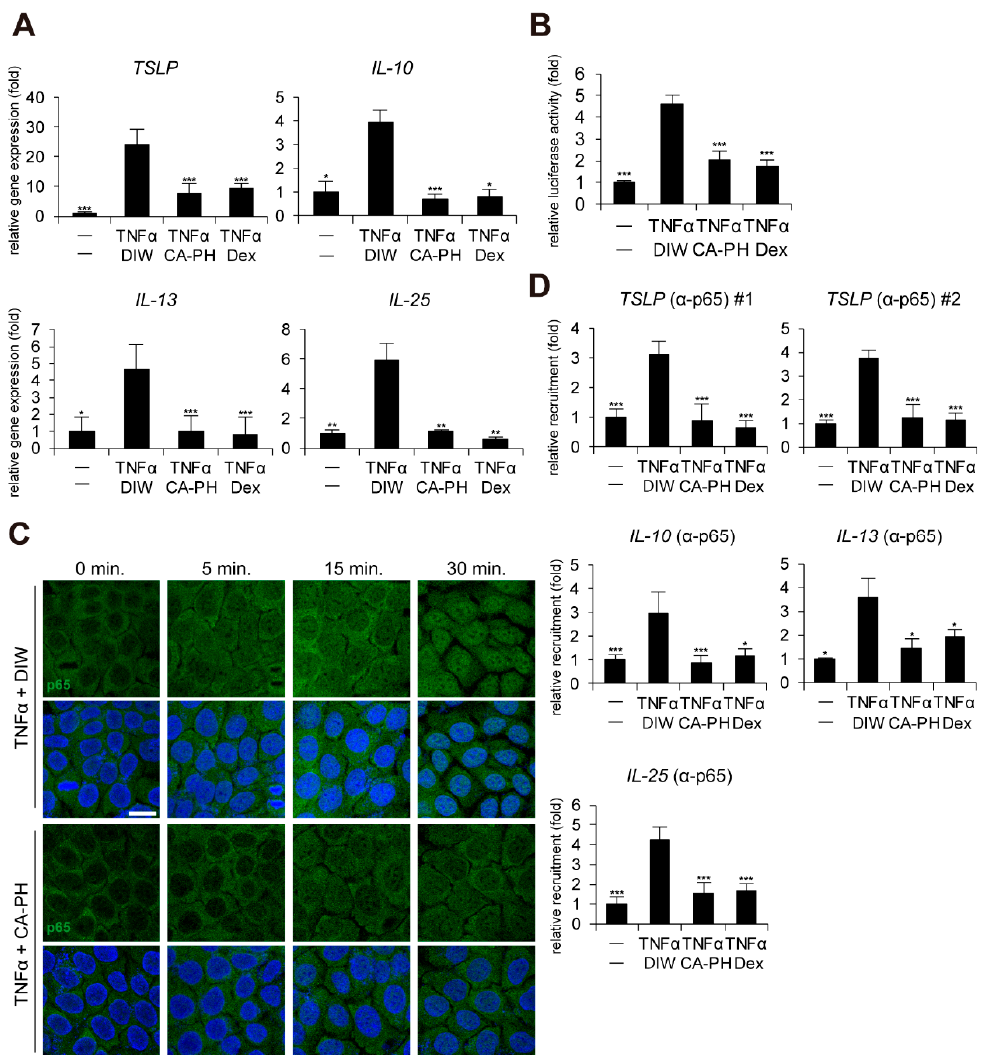
Figure 2. CA-PH inhibits NF- κ B signaling in TNF α -treated keratinocytes. ( A ) CA-PH suppresses DNFB-induced up-regulation of cytokine expression in TNF α -treated HaCaT keratinocytes. Dex was used as the positive control. DIW was used as a solvent for TNF α and CA-PH. Transcripts of TSLP, IL-10, IL-13, IL-25, and RPLP0 were quantified using real-time PCR ( n = 5). ( B ) CA-PH suppresses the activity of the luciferase reporter containing NF- κ B binding sites in TNF α -treated HaCaT keratinocytes. Dex was used as the positive control. DIW was used as the solvent for TNF α and CA-PH. Following transfection of the luciferase reporter vector containing NF- κ B binding sites and the control Renilla luciferase expression vector into HaCaT keratinocytes, luciferase activity was measured in cell extracts ( n = 5). Reporter activity is represented as the fold activation relative to Renilla luciferase activity. ( C ) CA-PH inhibits nuclear translocation of NF- κ B p65 in TNF α -treated HaCaT keratinocytes. Dex was used as the positive control. DIW was used as the solvent for TNF α and CA-PH. Cells were immunostained with anti-NF- κ B p65 antibody ( n = 5). Nuclei were identified using DAPI staining. Representative images are shown. Scale bar, 20 µ m. ( D ) TNF α induces the occupancy of NF- κ B p65 at the NF- κ B binding sites of TSLP, IL-10, IL-13, and IL-25 gene promoters in HaCaT keratinocytes. However, CA-PH decreases the occupancy of NF- κ B p65 in the gene promoters in HaCaT keratinocytes treated with TNF α . Dex was used as positive control. DIW was used as solvent for TNF α and CA-PH. ChIP assay was performed using anti-NF- κ B p65 antibody ( n = 5). The occupancy of each protein was quantified using real-time PCR in the gene promoters encompassing the NF- κ B binding sites. All data represent means ± S.E.M. Significance values were * p ≤ 0.05, ** p ≤ 0.01, and *** p ≤ 0.005. Dex, dexamethasone; DIW, deionized water; TNF α , tumor necrosis factor